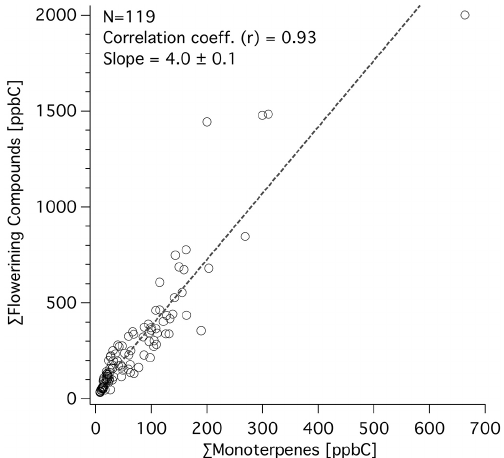
Figure 2. Comparison of total observed flowering compounds to the sum of monoterpenes during the spring at the Lindcove site. Concentrations were well correlated with a slope of 4.0, but can be expected to vary somewhat with the density of blossoms over the whole period of flowering. In addition to the flowering countdowns, large increases in monoterpenes concentrations were observed.